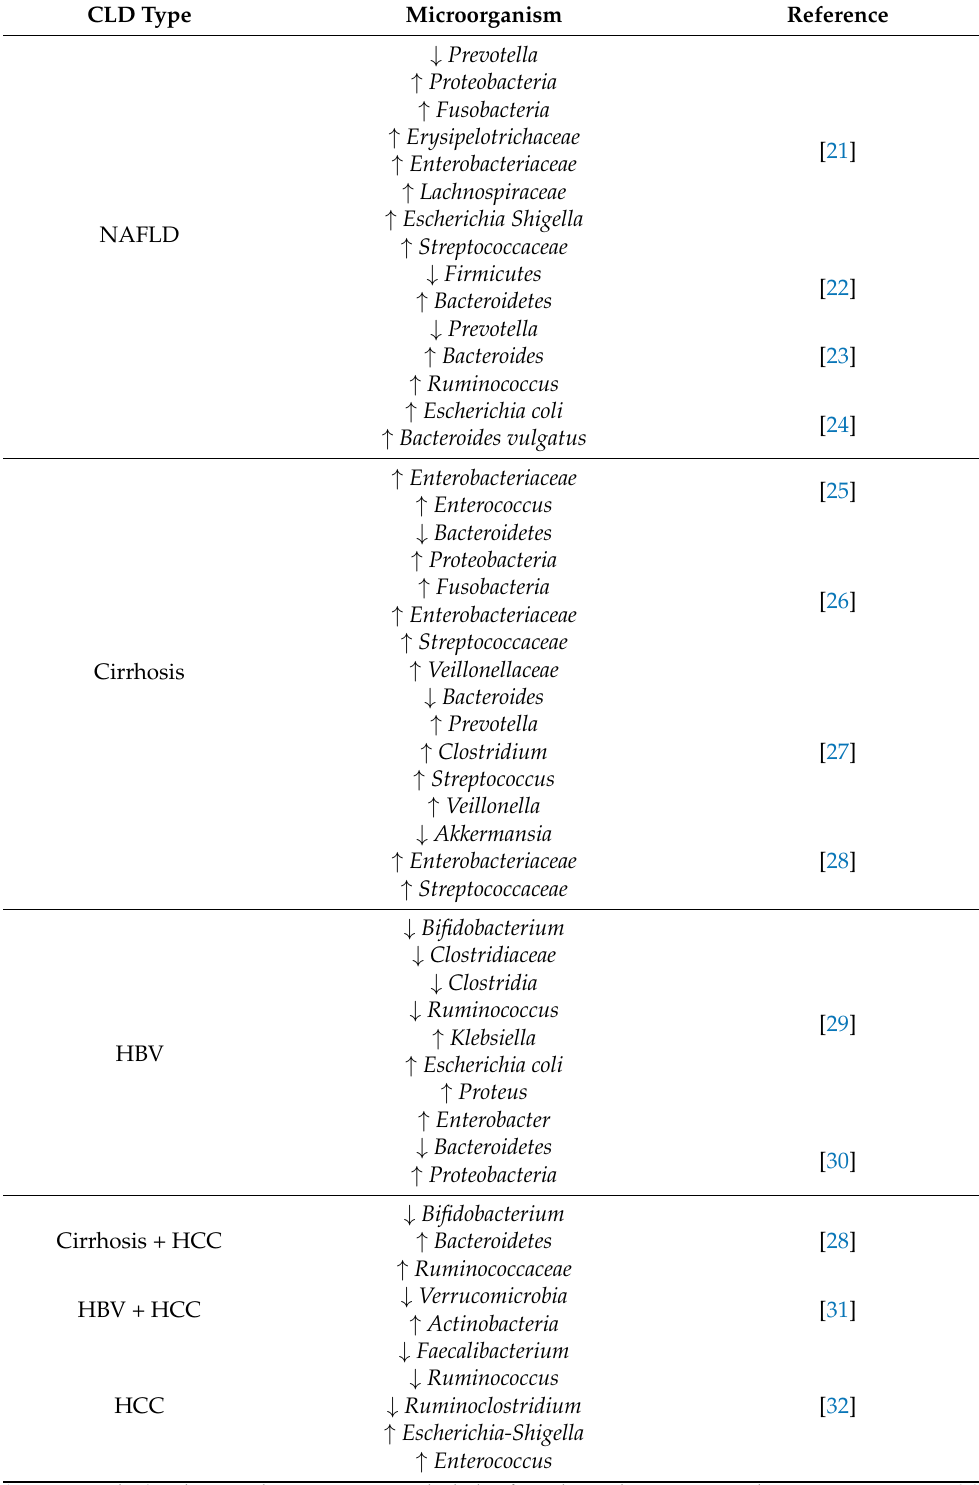
Table 1. Human studies involving gut microbial composition in various CLD